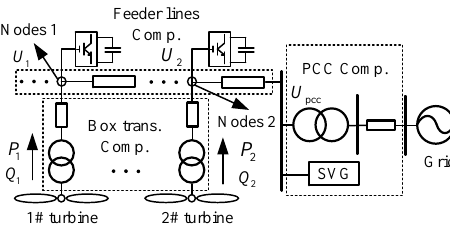
Figure 3. Voltage control diagram of wind farm.